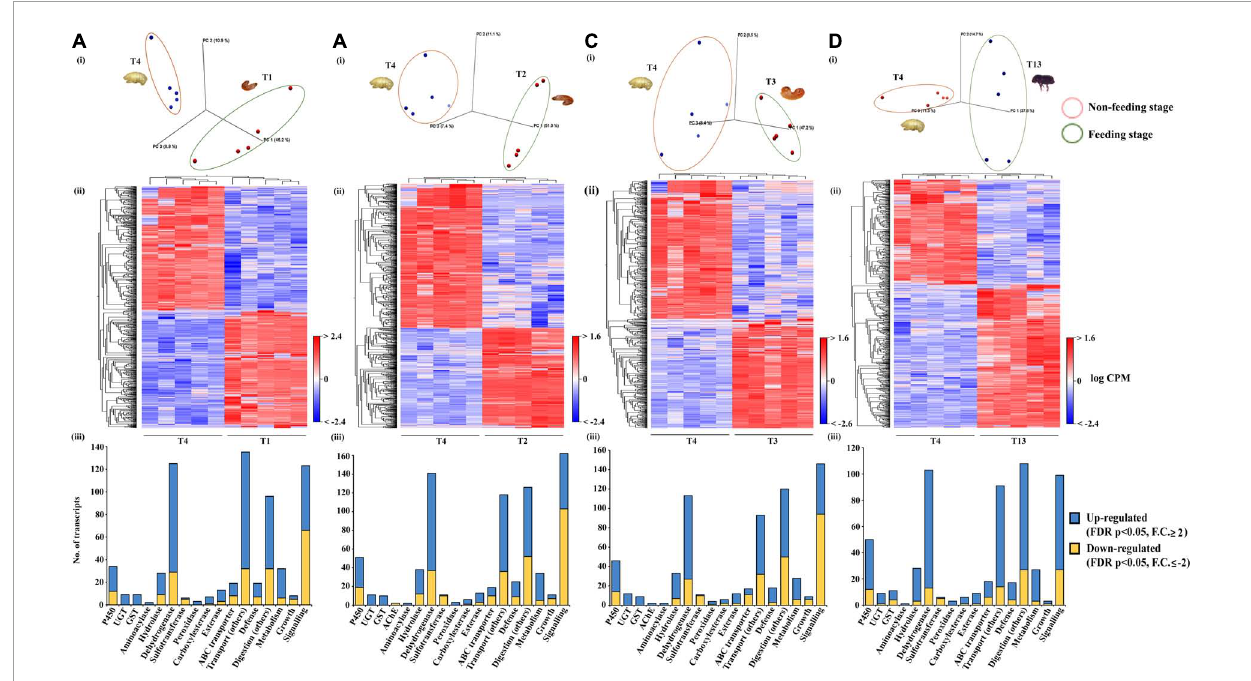
FIGURE4 Feeding vs. non-feeding stage comparison. Pupa (T4, non-feeding stage) was compared with different feeding stages (T1, T2, T3, and T13) ( N = 5). (A) PCA plot showing sample clustering. (B) Heat maps representing gene clustering. The color spectrum, stretching from blue to red, represents TMM-adjusted log CPM expression values obtained after DGE analysis. (C,D) Bar graphs showing differentially expressed contigs of detoxification-related enzyme families and other essential enzymes related to defense, digestion, transport, metabolism, signaling, and growth between the feeding vs. the non-feeding stage. Analysis was done using the CLC workbench using FDR p < 0.05 and fold change ± 2 as the threshold for